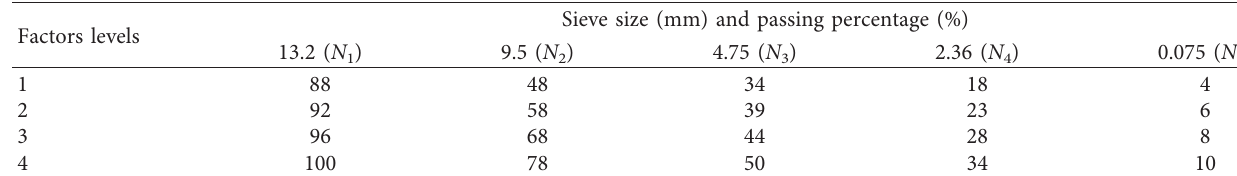
Table 7: Factors and levels of orthogonal test of